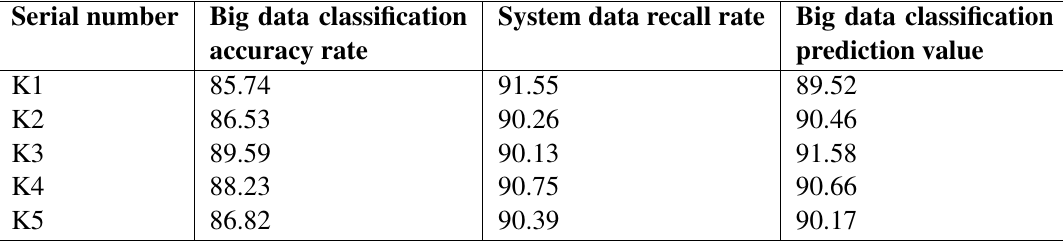
Table 2 Big data classification processing results based on orthogonal decomposition